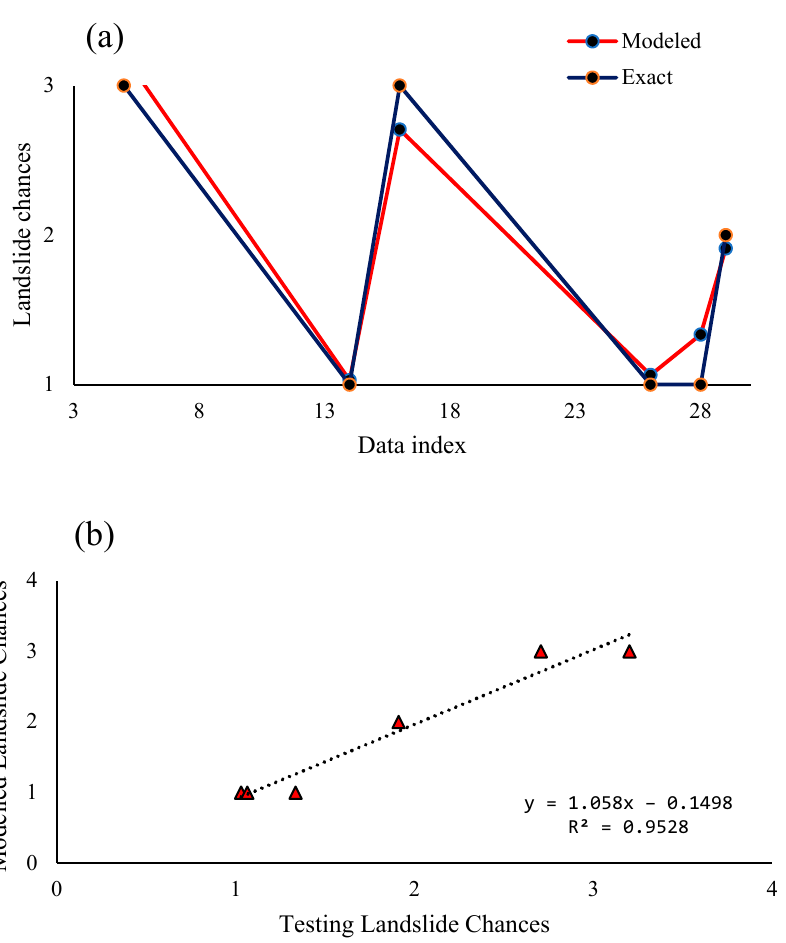
Figure 9. ( a ) Graph showing the predicted vs observed landslide chances (LC) using the MLR model against the model index values. ( b ) Predicted vs observed values for LC (1 Low , 2 Medium , and 3 High ).